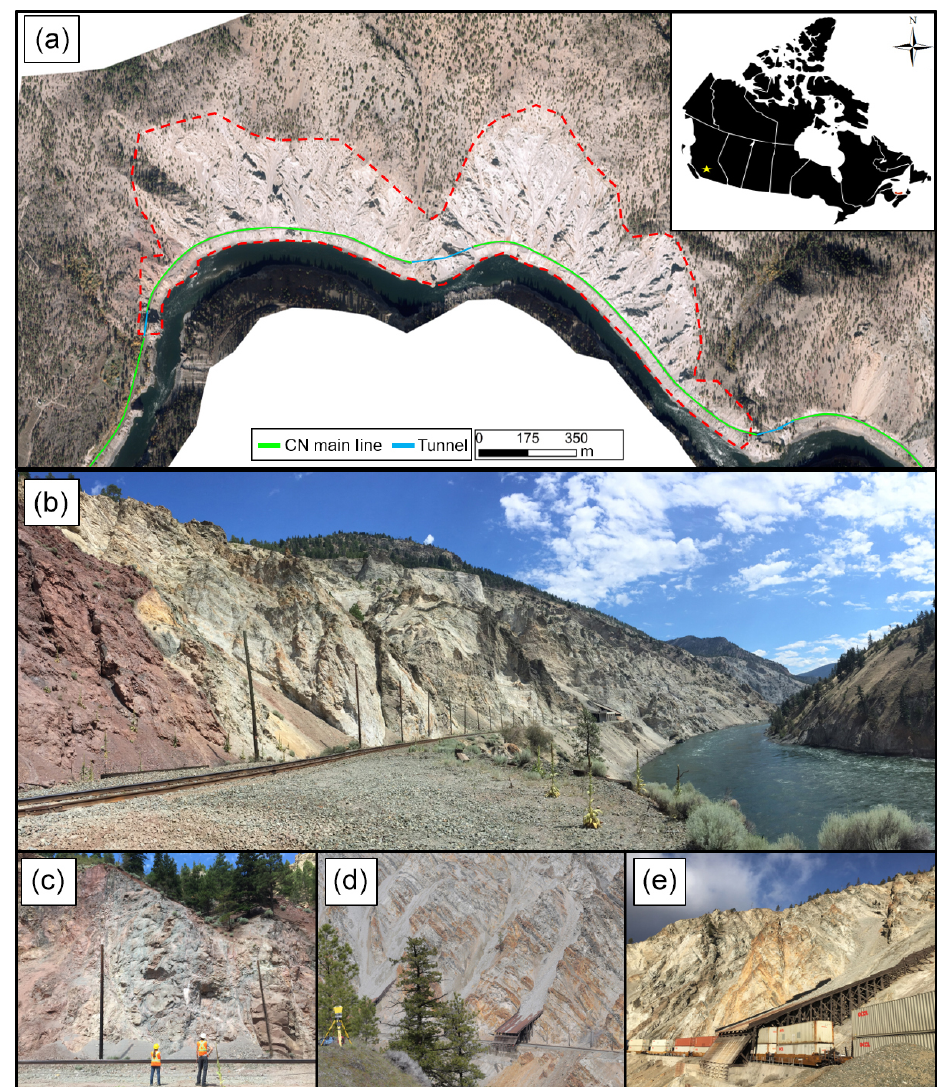
Figure 2. Location map of the White Canyon. (a) October 2015 orthophoto of the White Canyon. The White Canyon is delineated by the red dashed line. (b) July 2016 panoramic photograph from track level looking northeast at the complex morphology of the study slope. (c) July 2016 photograph from track level of the Mt. Lytton batholith. (d) April 2017 photograph displaying the TLS system setup looking at the study slope from across the Thompson River. (e) February 2018 photograph from track level looking at one of the rock sheds on the eastern portion of the canyon. The rock shed is 20m in